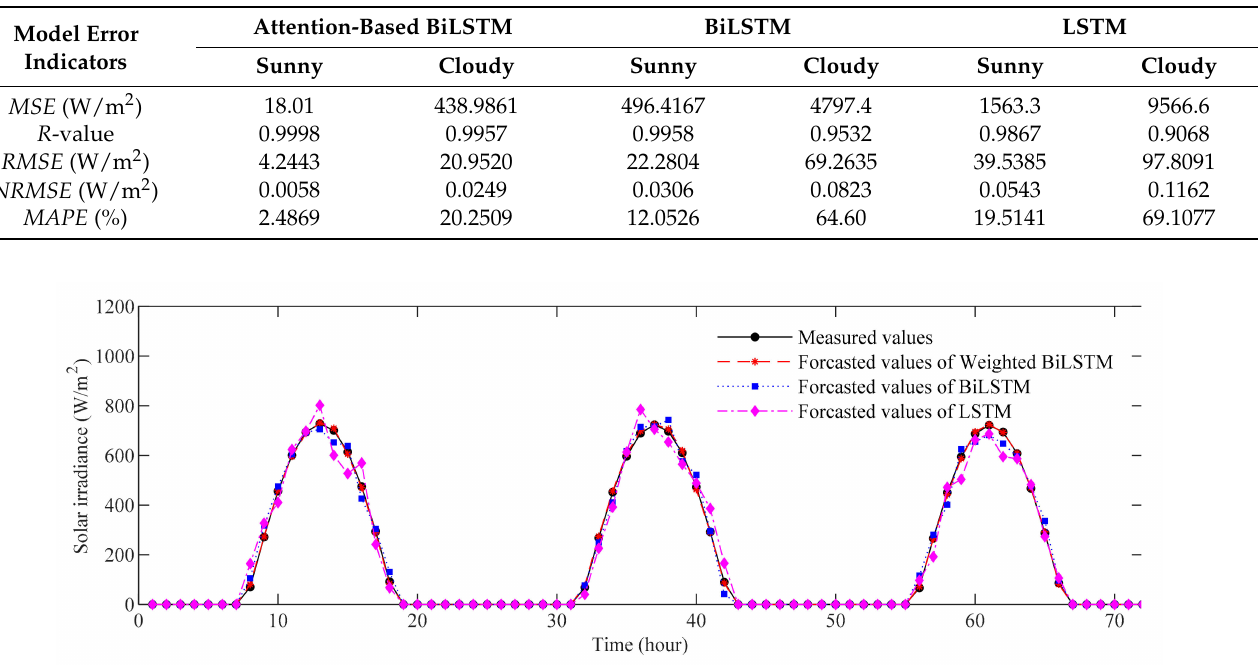
Figure 7. Forecast results obtained for sunny days.